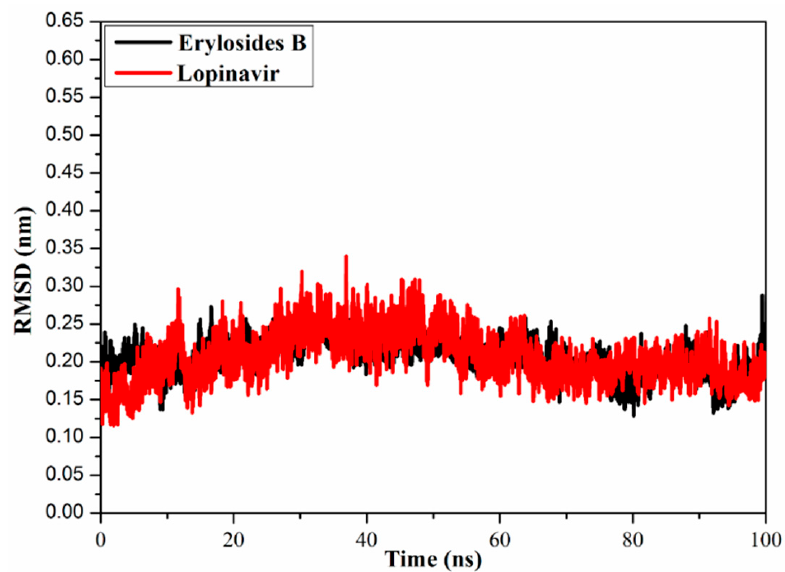
Figure 7. Root-mean-square deviation (RMSD) of the backbone atoms from the initial structure of erylosides B (black) and lopinavir (red) with M pro throughout a 100 ns MD simulation.